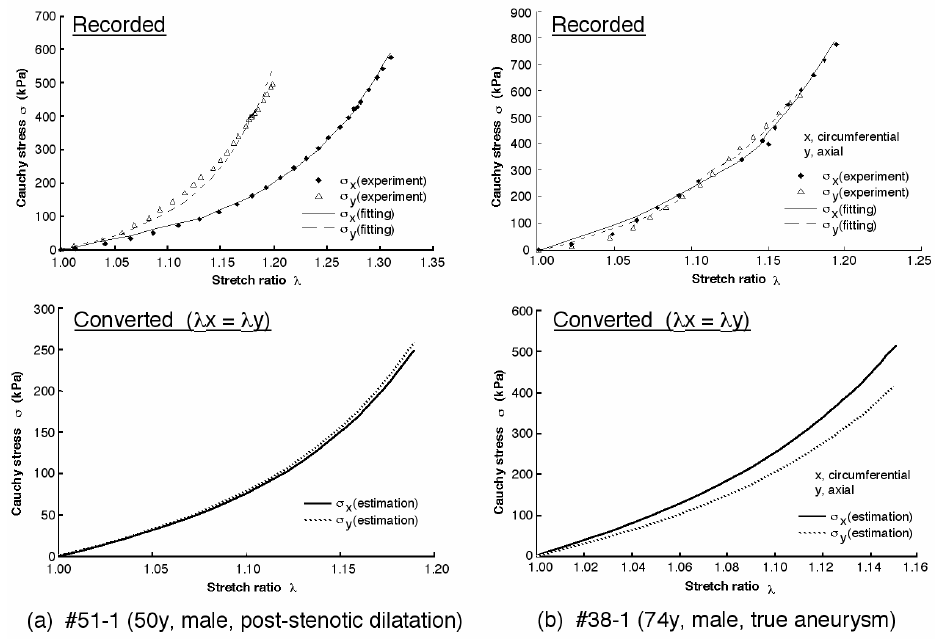
Fig. 3 Examples of stress-stretch ratio curves obtained in the experiment and their curve fit, and the curves converted for equibiaxial stretch